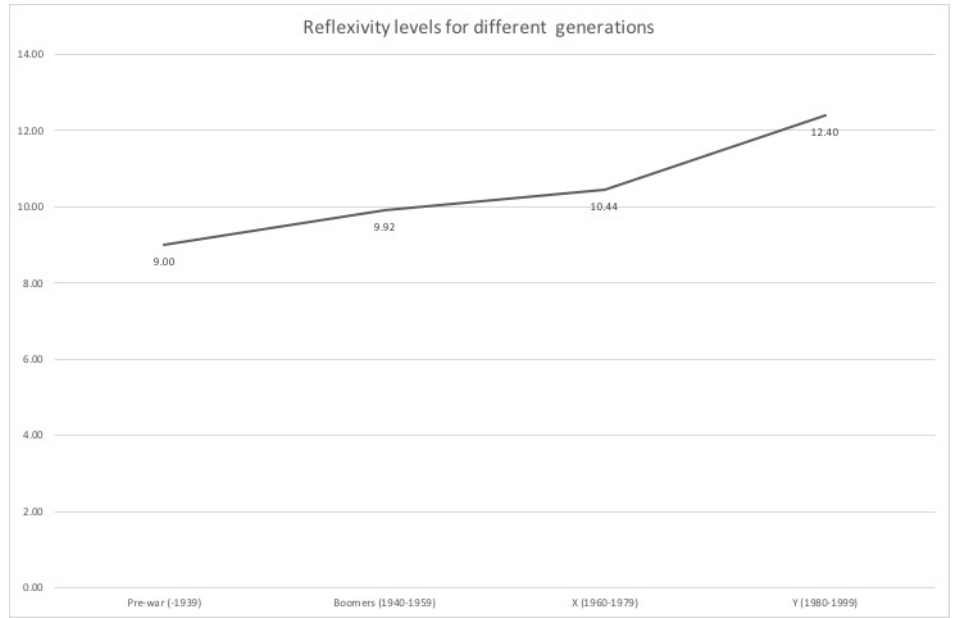
Figure 3. Reflexivity levels for different generations.